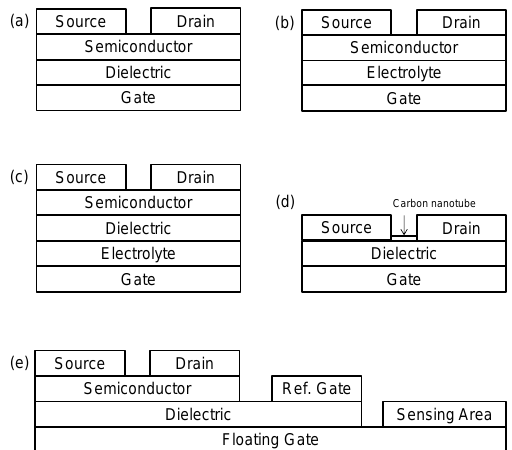
Figure 1. Simplified diagrams of various types of organic thin-film transistor (OTFT): ( a ) organic field effect-transistor (OFET) (bottom-gate, top-contact version shown); ( b ) electrolyte-gated organic field effect transistor (EGOFET); ( c ) ion-sensitive OFET (ISOFET); ( d ) carbon nanotube FET (CNTFET); and ( e ) organic charge-modulated FET